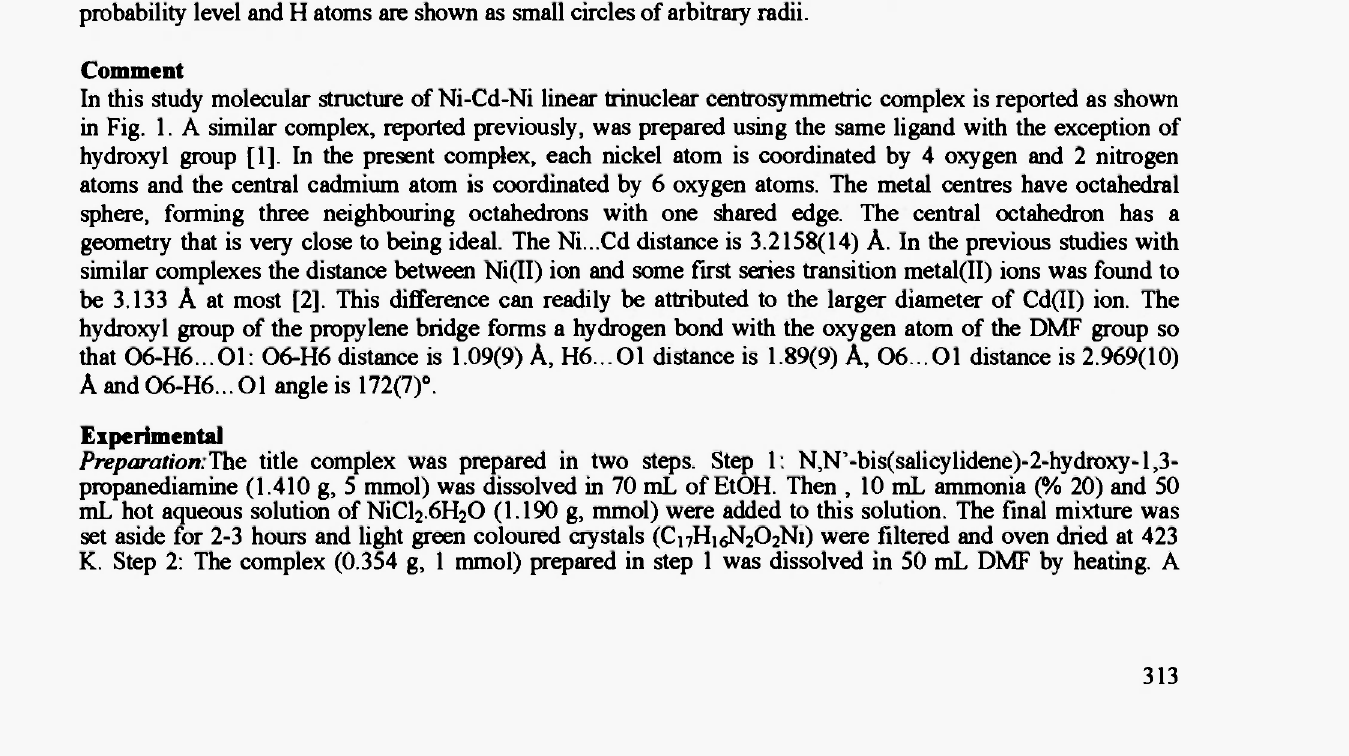
Figure 1. The ORTEP [3] drawing of the title complex. The displacement ellipsoids are drawn at the 50% probability level and Η atoms are shown as small circles of arbitrary